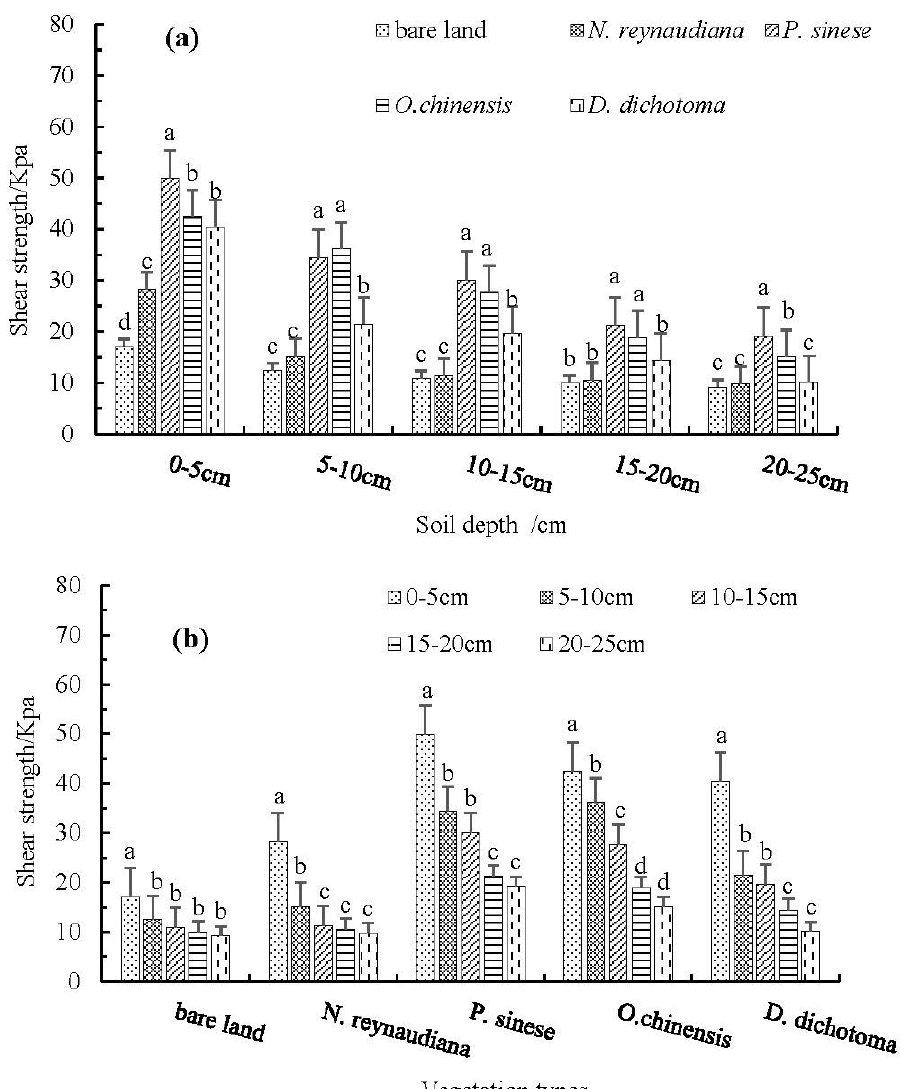
Figure 8. ( a ) Differences in shear strength of the vegetation types under different soil layers; ( b ) Soil shear strength of different vegetation types varying with soil depth. Significant differences between experiments are denoted by different letters.